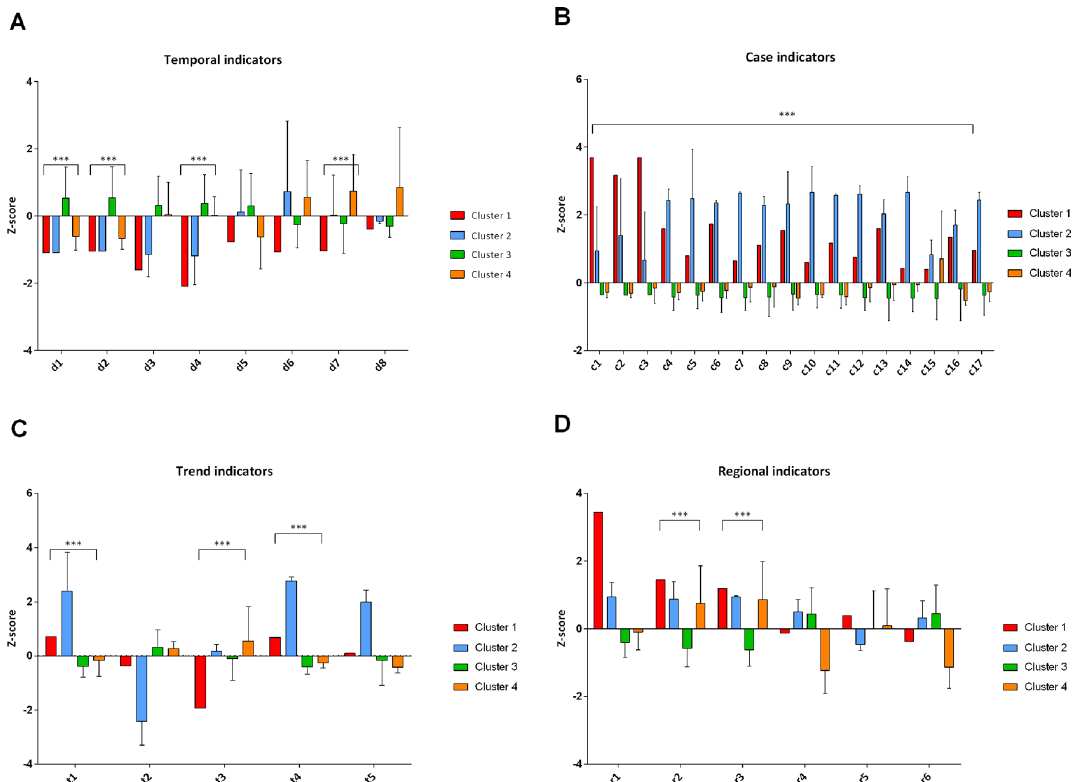
Figure 4. Comparison of SARS-CoV-2 epidemic indicators by clusters, after excluding Lombardy. This panel show the one-way analysis of variance (ANOVA) of temporal ( A ), intensity ( B ), trend ( C ), and regional ( D ) indicators across clusters. Statistical analysis was conducted after z-score standardization, and hence results can be interpreted as deviation from the national average (excluding data from Lombardy). *p < 0.001; **p < 0.0001; ***p <